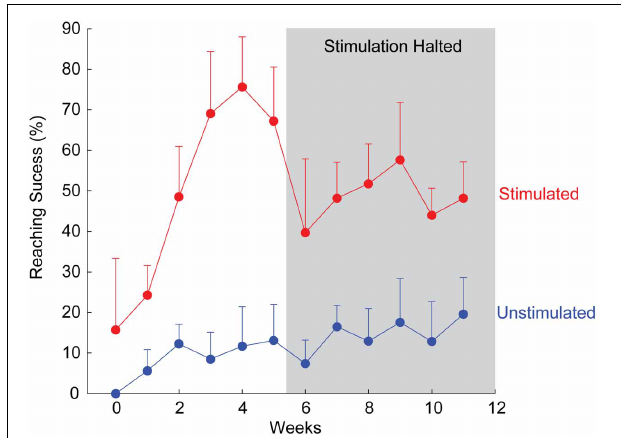
FIGURE 2 | Example of rapid recovery of forelimb reaching ability for one animal receiving therapeutic ISMS, compared to an unstimulated animal. After 5 weeks, stimulation was halted due to implant failure, allowing examination of sustained recovery with no further stimulation. Mean + SD for each